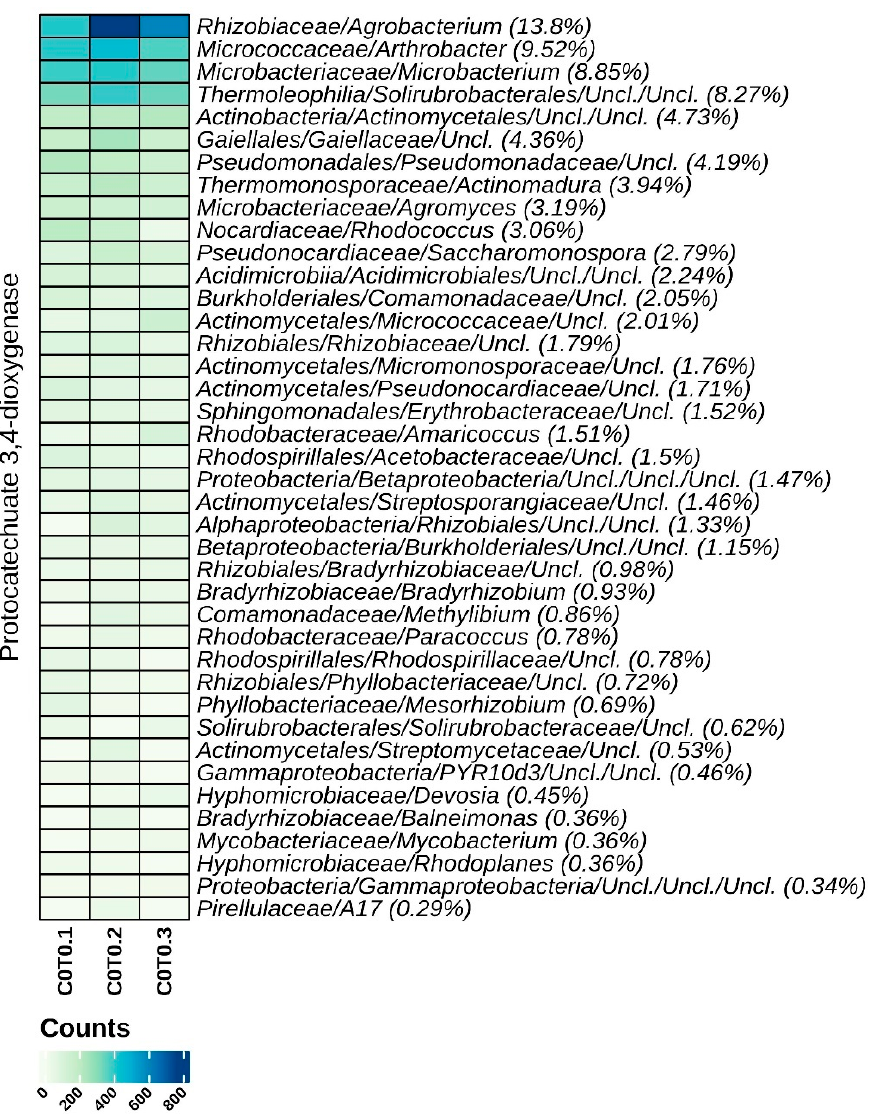
Figure 6. Functional Heatmaps of the Protocatechuate 3,4-dioxygenase contribution by identified ASVs aggregated at the Genus level, as inferred by PICRUSt2 in the three biological replicates. On rows, the nearest identified taxonomic level for each contributing ASV is reported, followed by its relative percentage contribution to the functional feature. Hierarchical clustering of columns was performed by Pearson correlation, based on Euclidean distance.